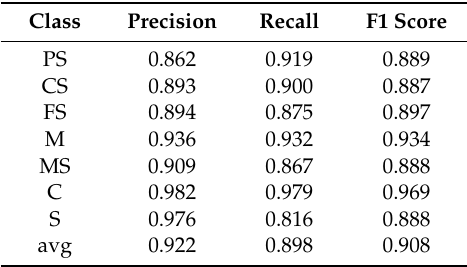
Table 4. Performance matrix of each lithology class for 5-fold-cross-validation averaged over ten runs in the HGF.